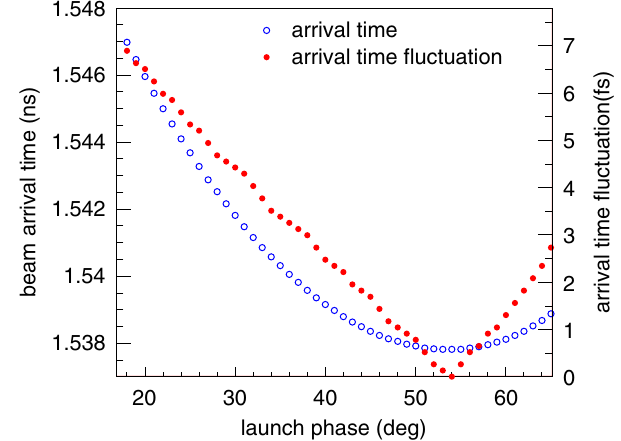
FIG. 14. Beam arrival time at 0.45 m depending on the launch phase (blue nonfilled circle) and arrival time fluctuation caused by 0.014 (cid:3) gun phase jitter (red filled circle). The sensitivity becomes smaller as launch phase increases until about 54 (cid:3) and then becomes larger again. At about 54 (cid:3) , the sensitivity is zero. This arrival time fluctuation from gun rf phase is also partially compensated by the rf buncher (see Fig. 16 and the discussion in the text).